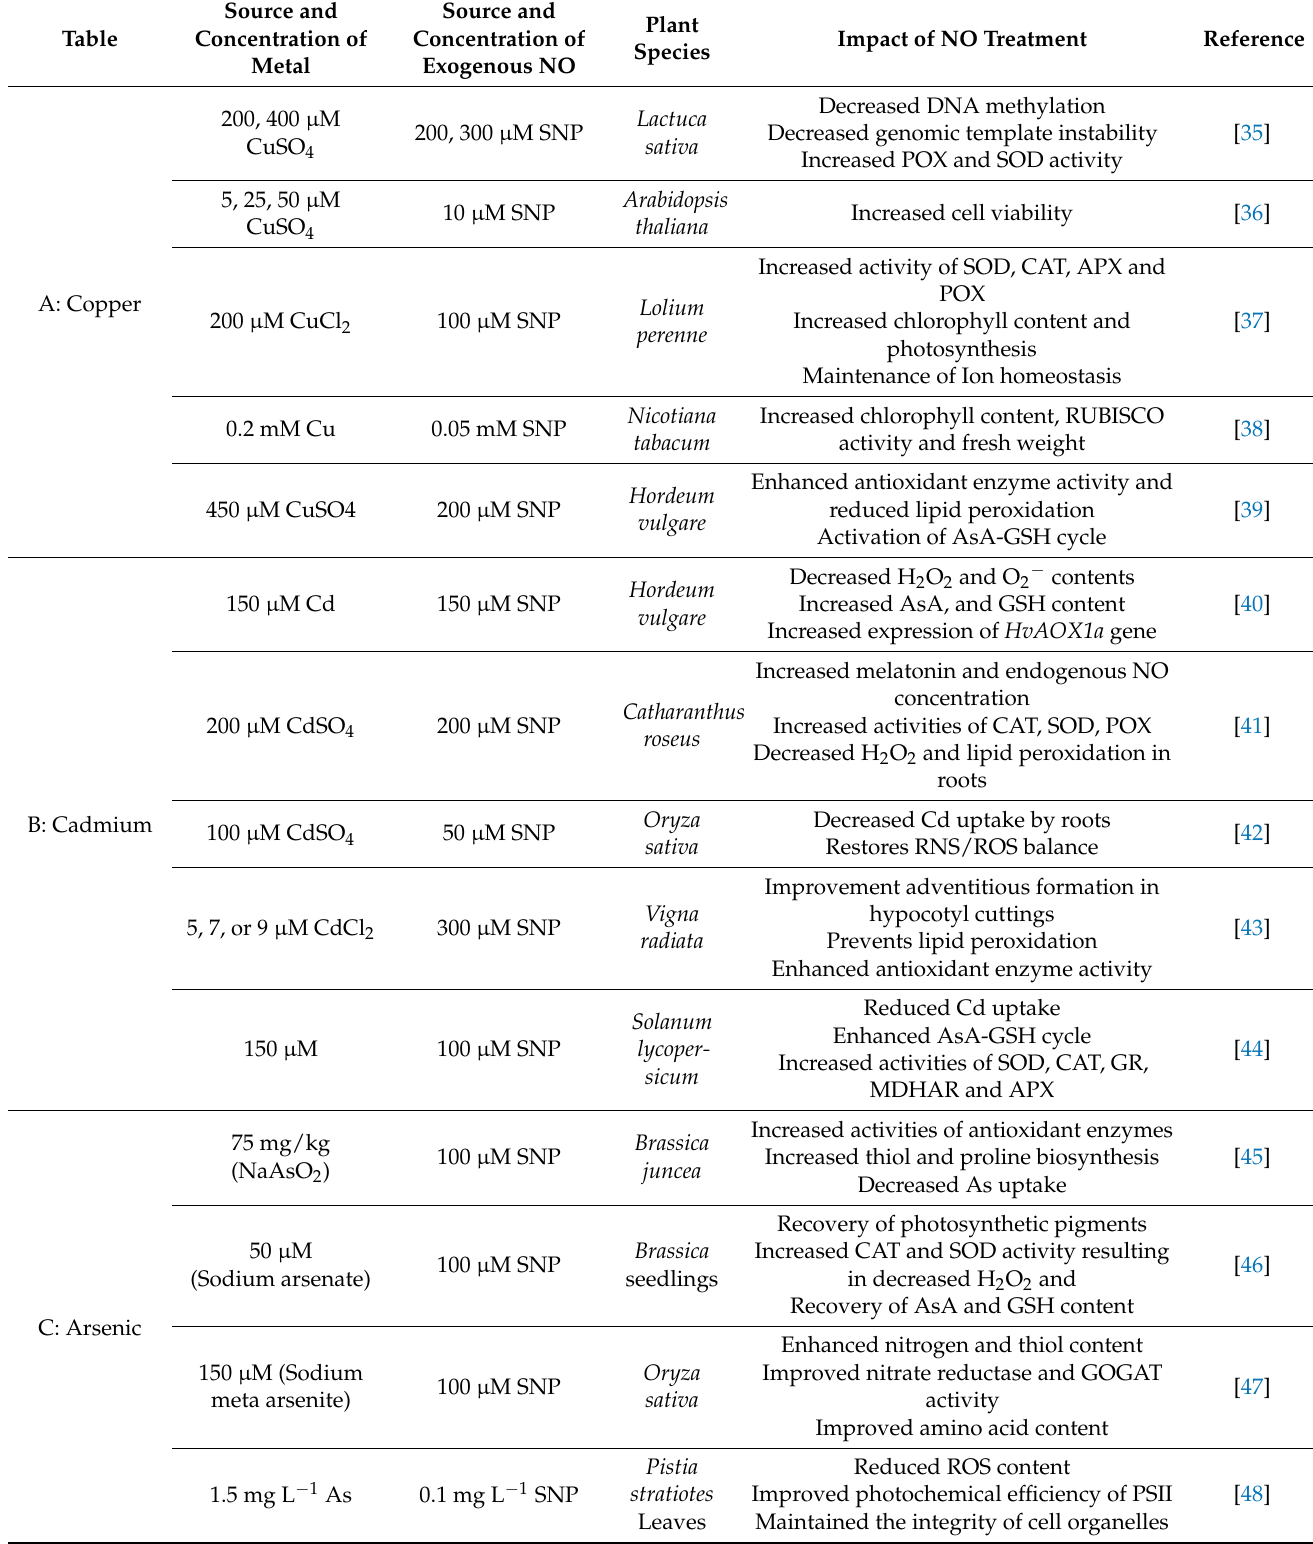
Table 2. Compilation of recent studies on the effects of exogenous NO application on plants under heavy metal stress. Source Table